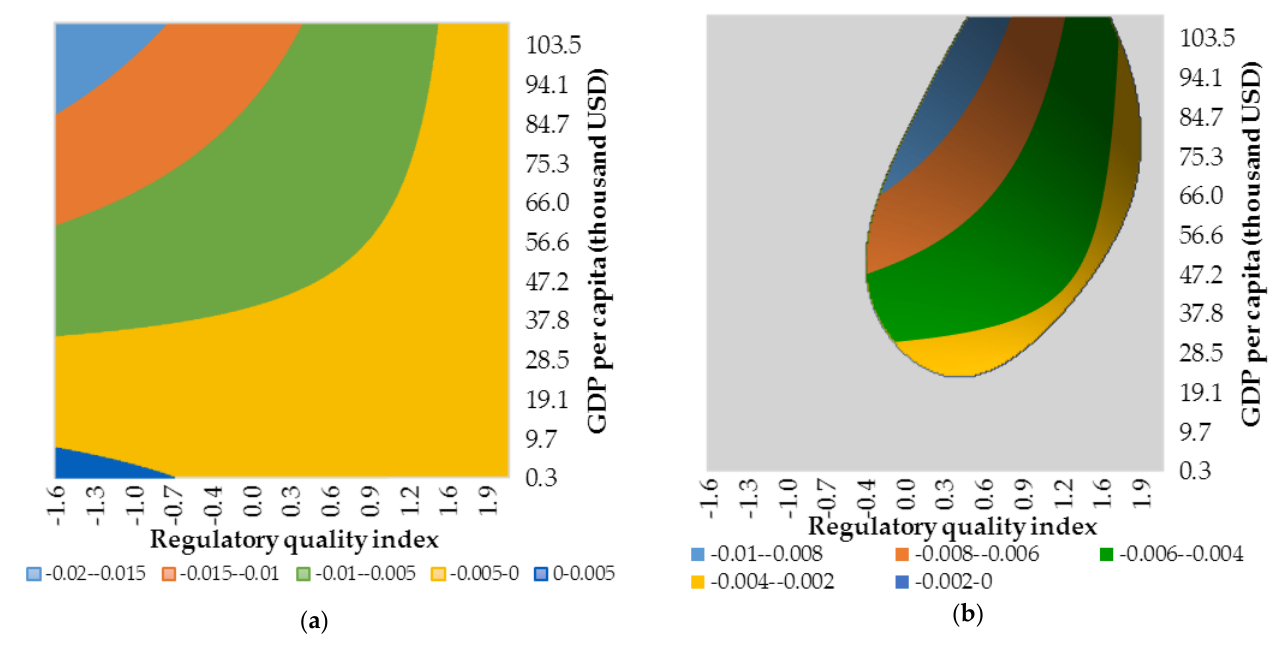
Figure A22. Conditional effect of financialisation on growth based on Est. 22 in Table A2. ( a ) Estimated conditional slope coefficient over the whole range of observed values for institutional quality and development level. ( b ) Estimated statistically significant conditional slope coefficient. Gray represents a combination of institutional quality and development level for which effect of financialisation on growth is statistically insignificant. Source: authors’ contributions.